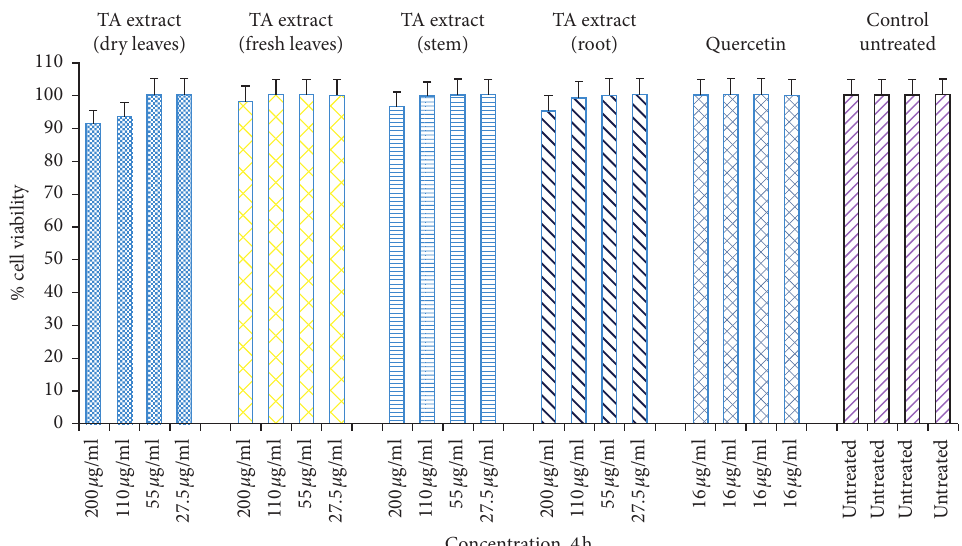
Figure 2: Cell viability determined by MTT assay. Hs27 skin fibroblasts were seeded at a density of 10,000 cells/well in 96-well plates and allowed to incubate overnight to attach to the surface. Next day, treat the cells with TA extracts (fresh and dry leaf, stem, and root extracts) for 4 h along with quercetin as a positive control (16 μ g/mL) and control as untreated. Data shown as mean ± SEM; n � 3 and ∗ p < 0 .